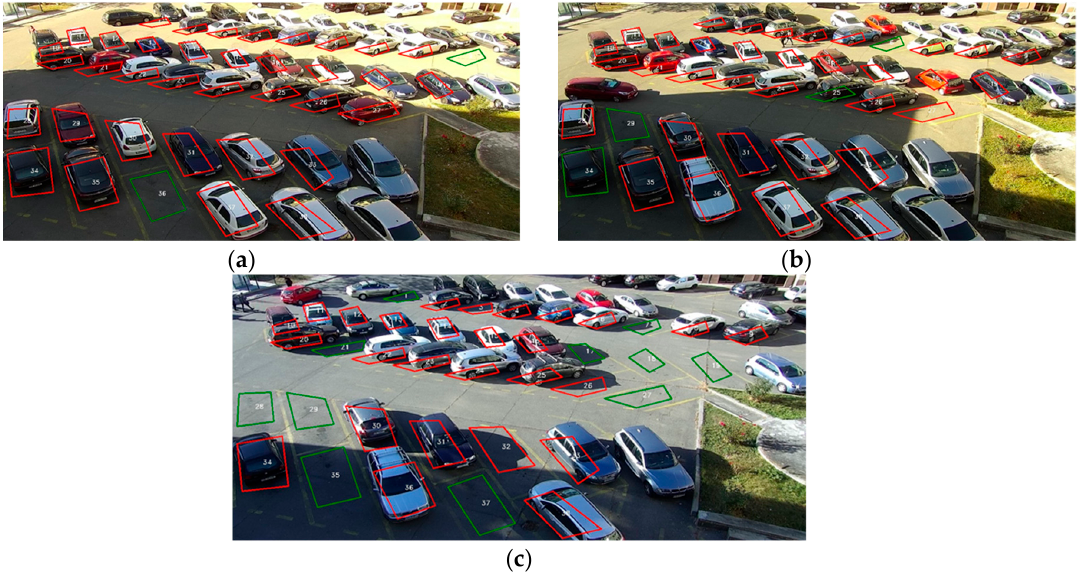
Figure 14. Detection of parking lot 2 availability: ( a ) the before direct sunlight; ( b ) with direct sunlight; ( c ) at the end of the day.